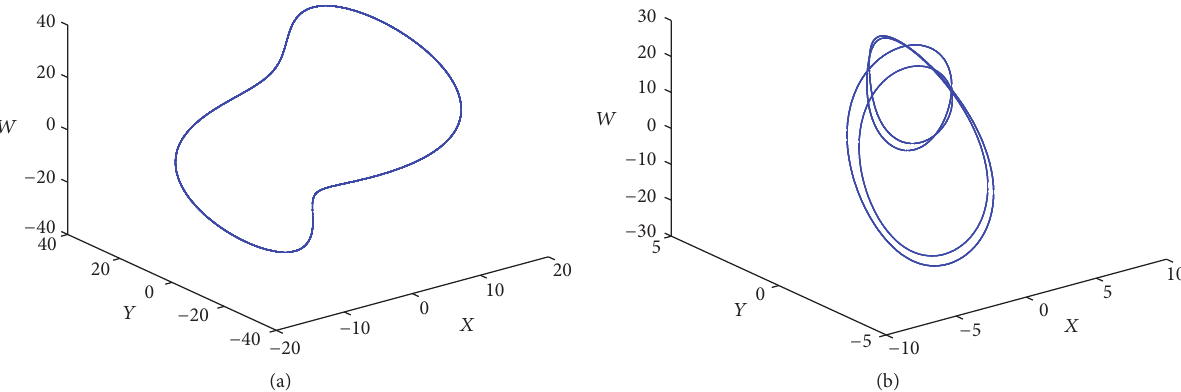
Figure 8: Complex limit cycle for (a) {𝑎 = 10 and 𝑑 = 3} and (b) {𝑎 = 50 and 𝑑 = 2} . Projection over the subspace XYW .